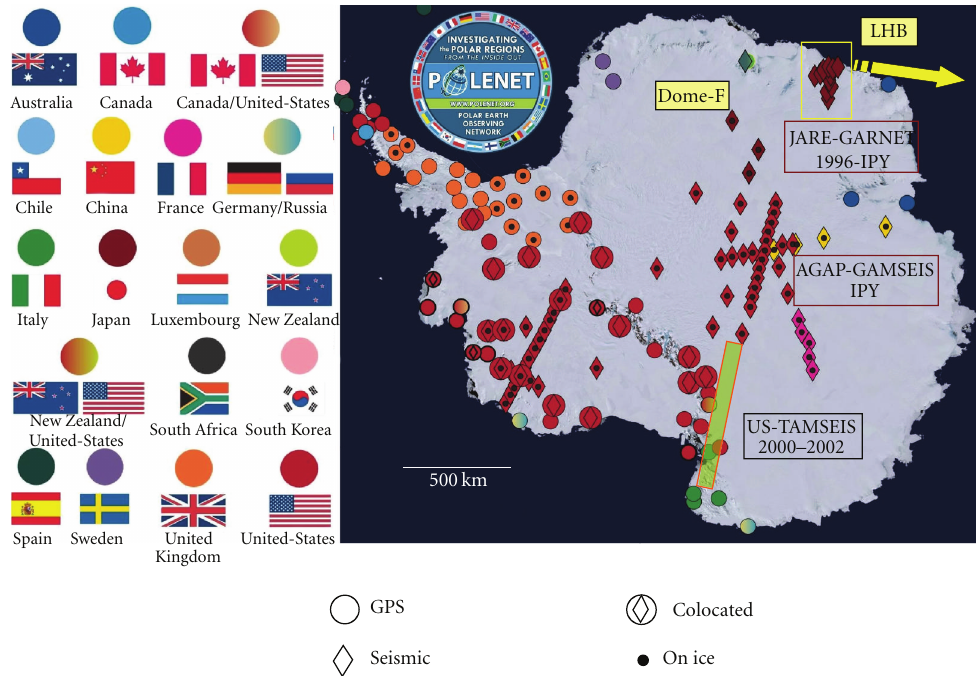
Figure 1: Distribution map of seismic and the other geophysical stations planned for deployed during IPY 2007-2008. The GARNET-JARE project regions are shown, as well as those of AGAP/GAMSEIS and TAMSEIS. All stations in Antarctica contribute to the POLENET program in the bipolar region. The LHB map is extended in Figure